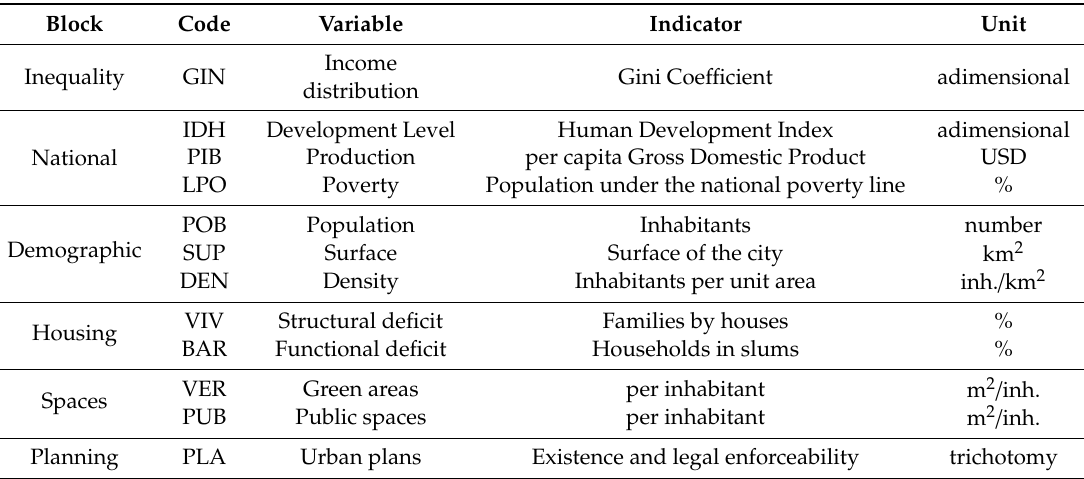
Table 1. System of variables and operational definitions.